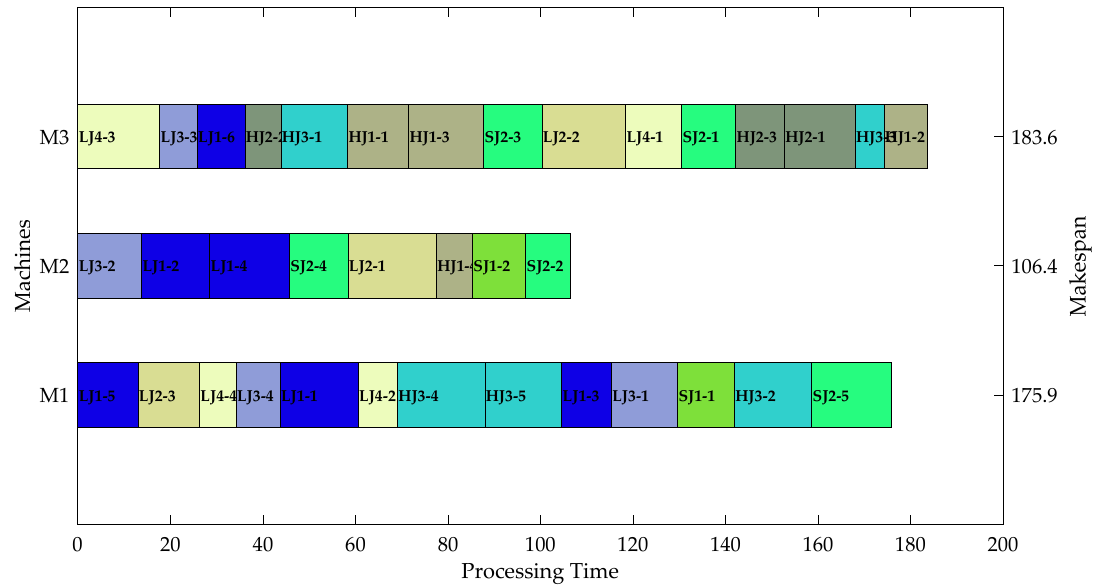
Figure 12. Gantt chart of metal structural parts processing.